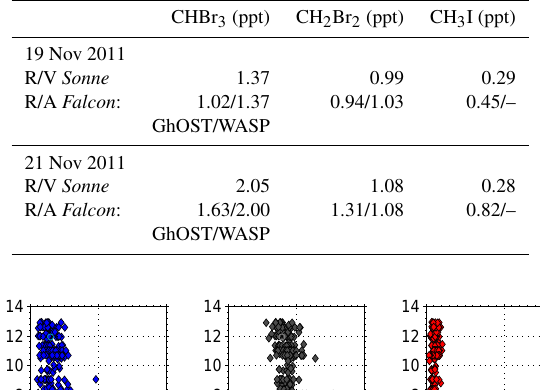
Table 2. Mean atmospheric mixing ratios of CHBr 3 , CH 2 Br 2 and CH 3 I observed on R/V Sonne and R/A Falcon during two case stud- ies on 19 November 2011 at 3.2 ◦ N and 112.5 ◦ E and on 21 Novem- ber 2011 at 4.6 ◦ N and 113.0 ◦ E. During the two meetings two (one) measurements have been taken by R/V Sonne , 20 (5) measurements on R/A Falcon by GhOST and 17 (21) by WASP.